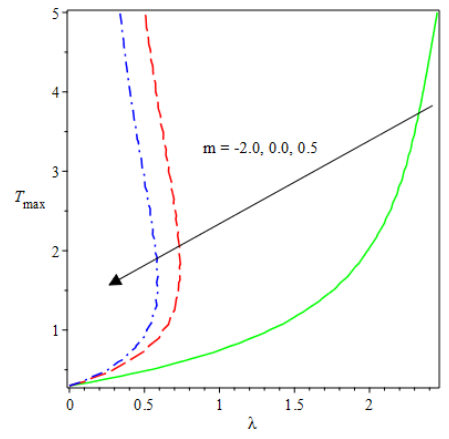
Figure 16. Bifurcation slice for various ( α ) .